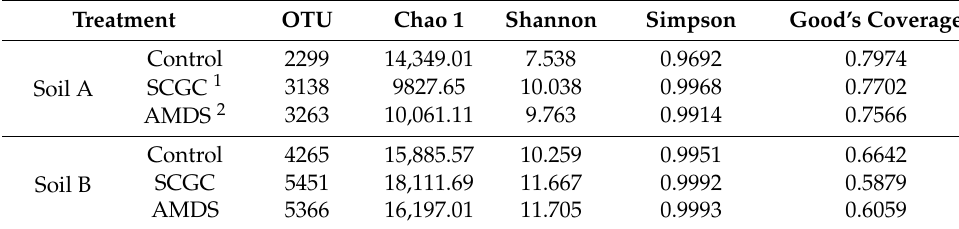
Table 3. Number of operational taxonomic unit (OUT), estimated OUT richness (Chao 1), Shannon and Simpson diversity indices, and estimated sample coverage (Good’s coverage).